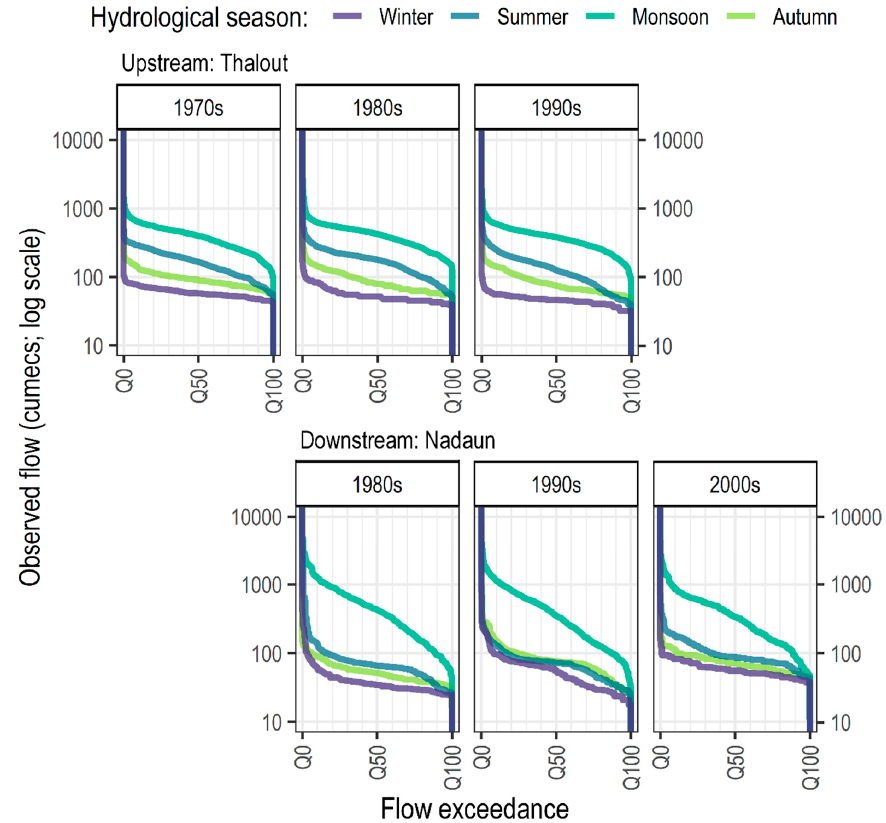
Figure 4 . Flow exceedance curves for each gauging station, by decade and hydrological season. Table 2. Months corresponding to the hydrological and ecological seasons in the Beas River, ordered by hydrological year (beginning in October).